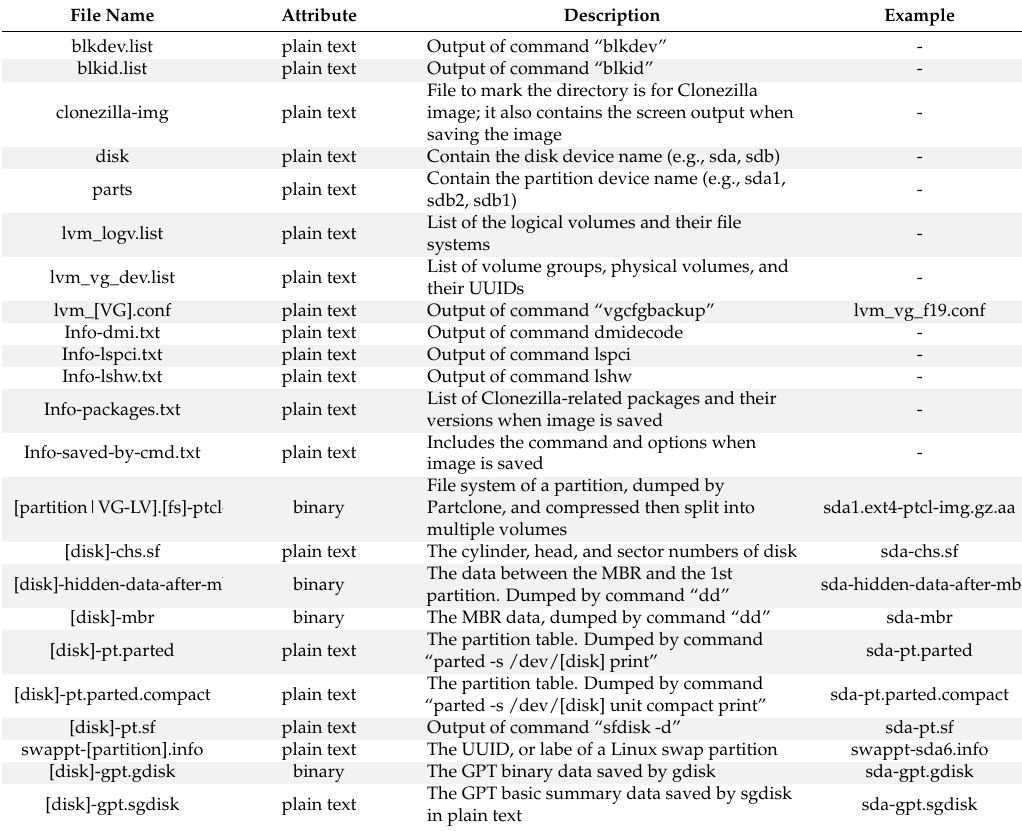
Table 1. Files in a Clonezilla image